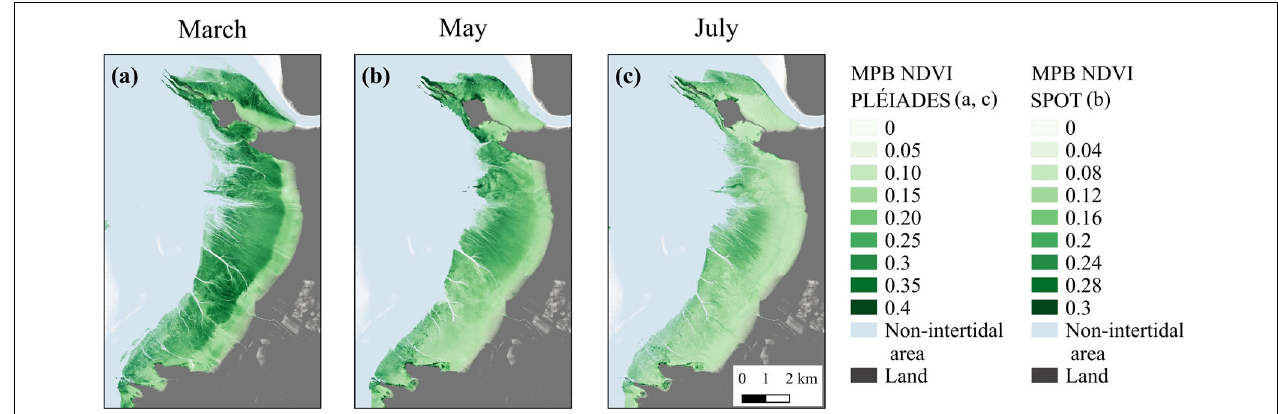
FIGURE 6 | MPB-specific NDVI from Pléiades satellite, March 3, 2018 (a) , and July 17, 2015 (c) , and from SPOT6 satellite, May 6, 2015 (b) .